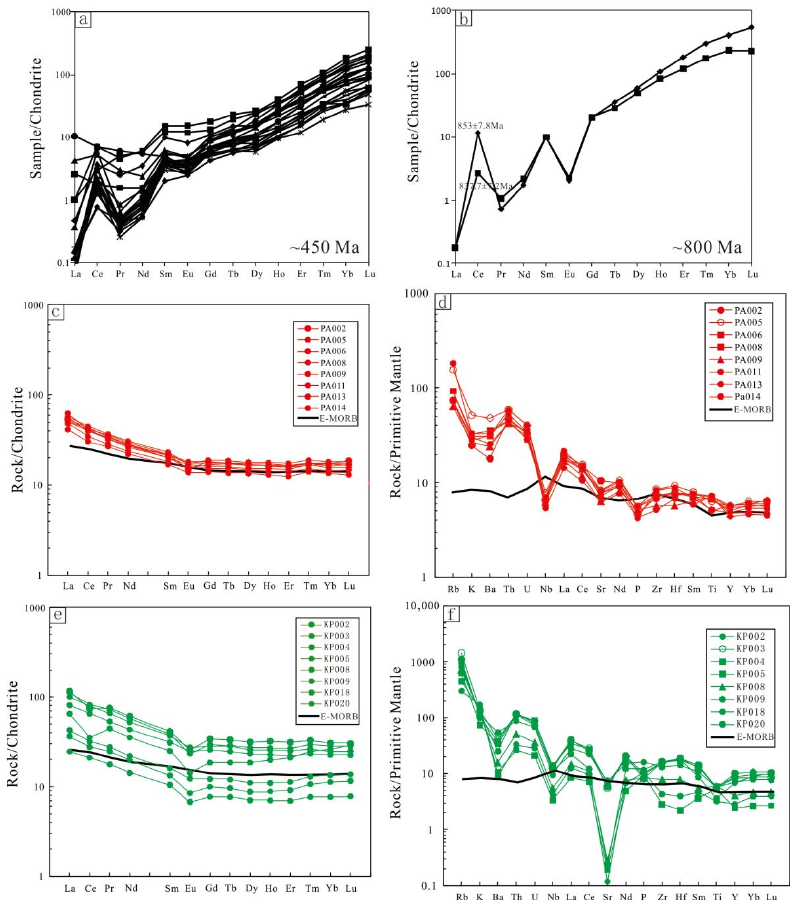
Figure 5. The corresponding chondrite–normalized distribution of the REE in the zircon crystals ( a , b ); ( c , d ) unaltered gabbro; and ( e , f ) altered gabbro.